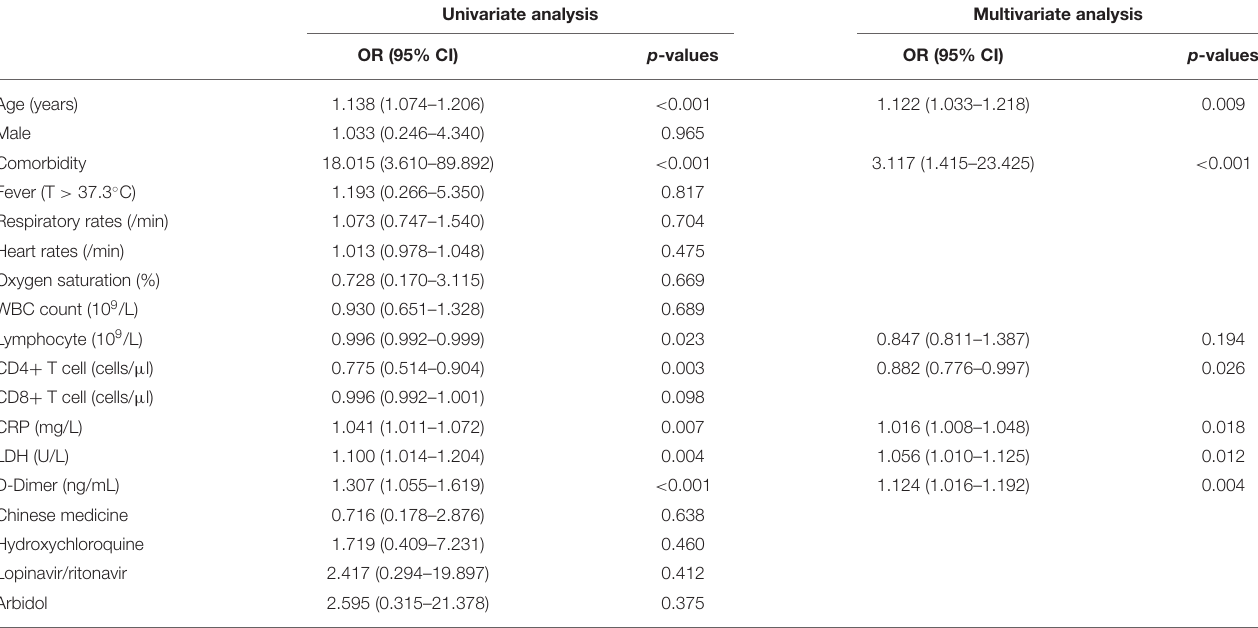
TABLE 2 | Variables associated with primary clinical